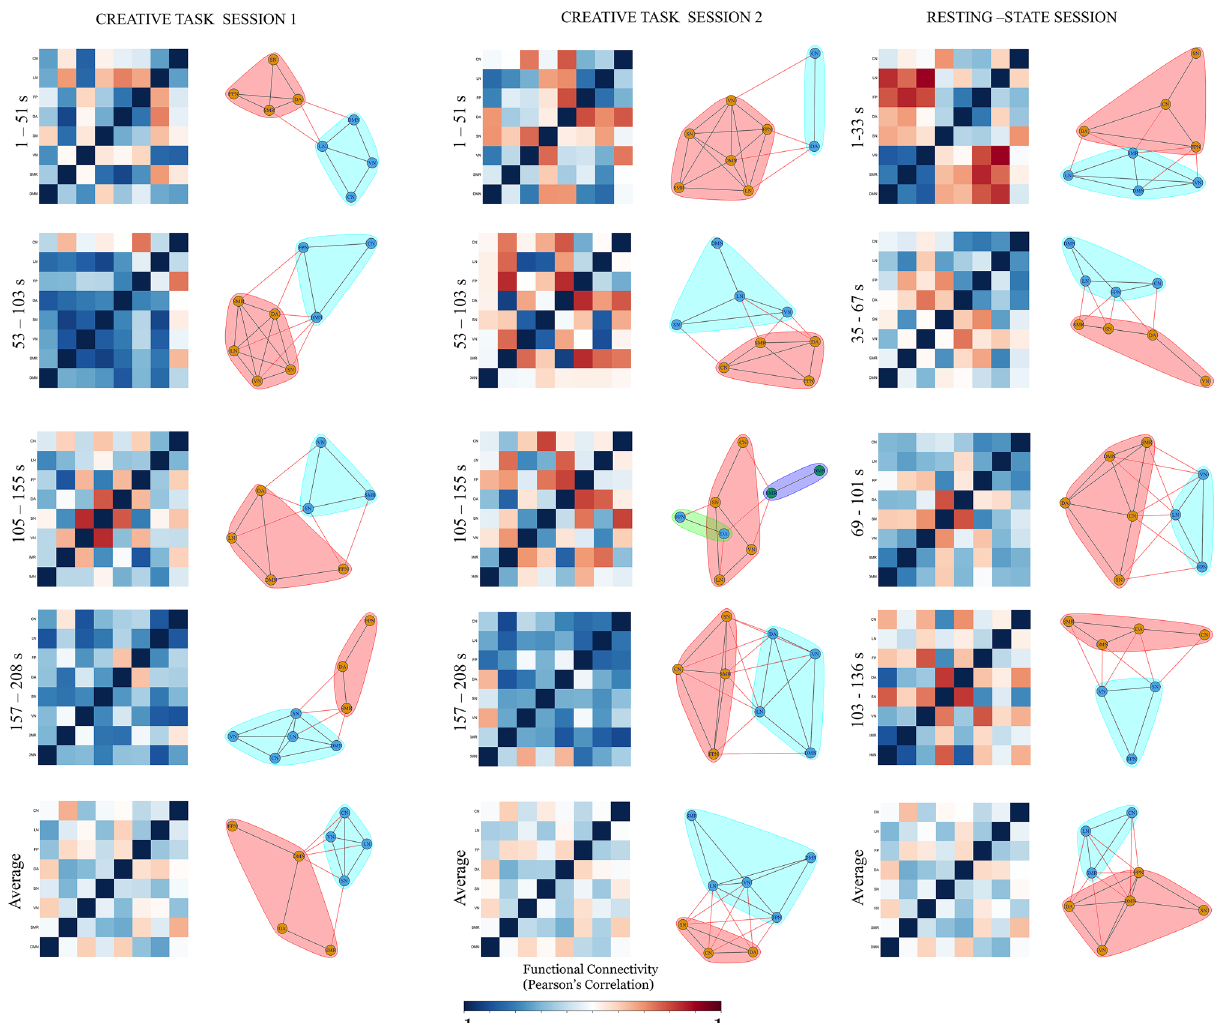
Figure 4. Network-specific dynamic re-configuration of creative brain using sliding window approach (window size = 44 s) for creative task session 1, creative task session 2 and resting-state session. The 32 BOLD time series signals representing 32 ROIs were averaged to form 8 distinct networks. The first column in each session indicates the single windowed correlation map between these times. The bottom row indicates the average of all the first four rows across all the sessions. Second column in every session indicates the graph representation and community detection formed using the fast-greedy algorithm community detection. Each colour indicates community formation for every session, averaged and every windowed correlation map. The edge color here represents the connection within the same community (same edge color of that of the community) or from one community to the other community (edge color of one community indicates the connection from that community to the other). Node Label List: DMN default mode network, FP frontoparietal network, SMR somatomotor network, DA dorsal attention network, SN salience network, VN visual network, LN language network, CN cerebellar